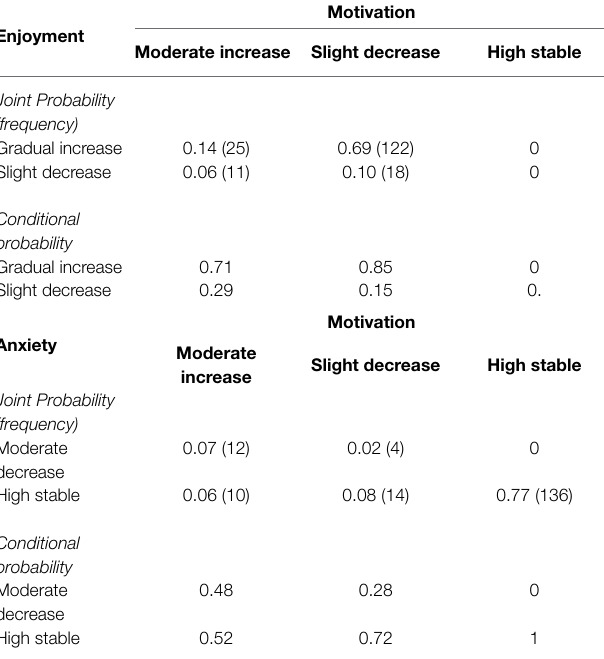
TABLE 3 | Joint and conditional probabilities for motivation and emotions.